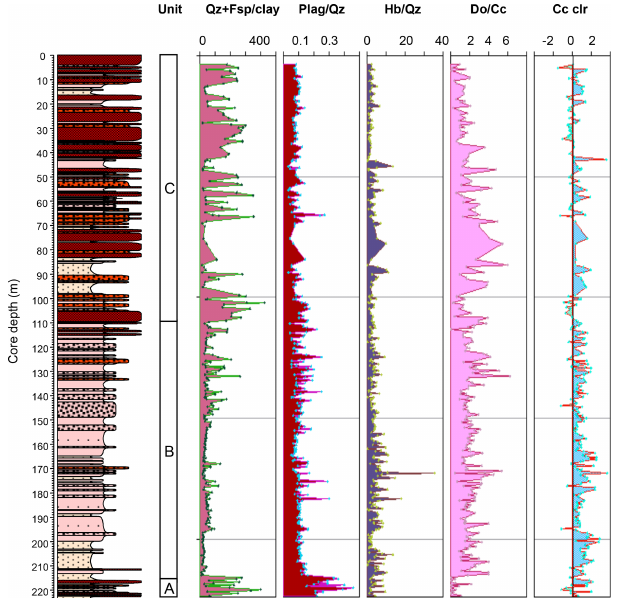
Figure 6. GN200 core with mineral distributions from XRD bulk measurement. Qz = quartz, Fsp = feldspar, Plag = plagioclase, Hb = hornblende, Do = dolomite, Cc = calcite. (clr = centred-log ratio).